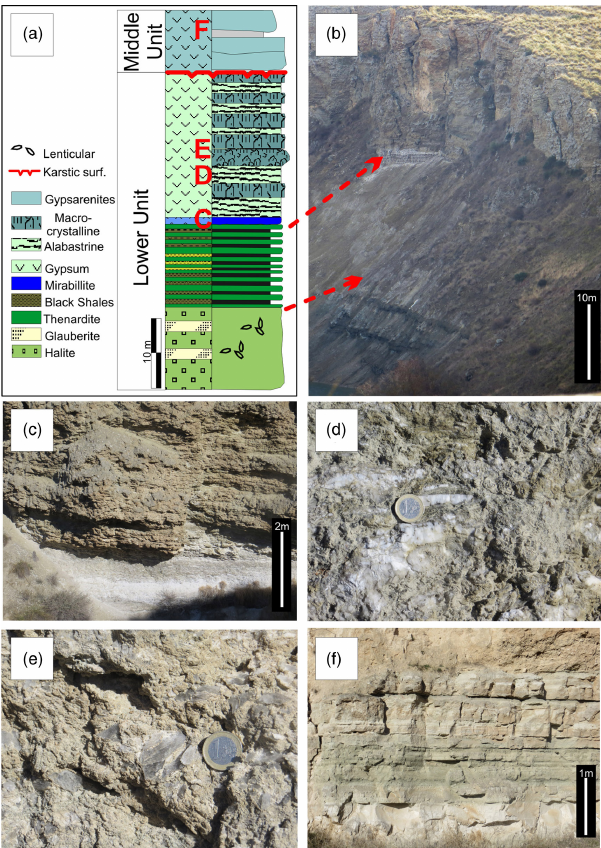
Figure 2. (a) Stratigraphic section of the upper part of the Lower Unit and the lowermost part of the Middle Unit of the Miocene in the Tajo basin. (b) General view of the Lower Unit outcrop- ping along the current Tajo River (south bank). (c) Outcrop view of the contact between the upper part of the thenardite body and the overlaying unit with secondary gypsum. This secondary gyp- sum appears as two main lithofacies: (d) alabastrine gypsum, and (e) macro-crystalline gypsum (the coin for scale is 2.2cm in diame- ter). (f) Outcrop of the detritic gypsum beds that comprise the lower part of the Middle